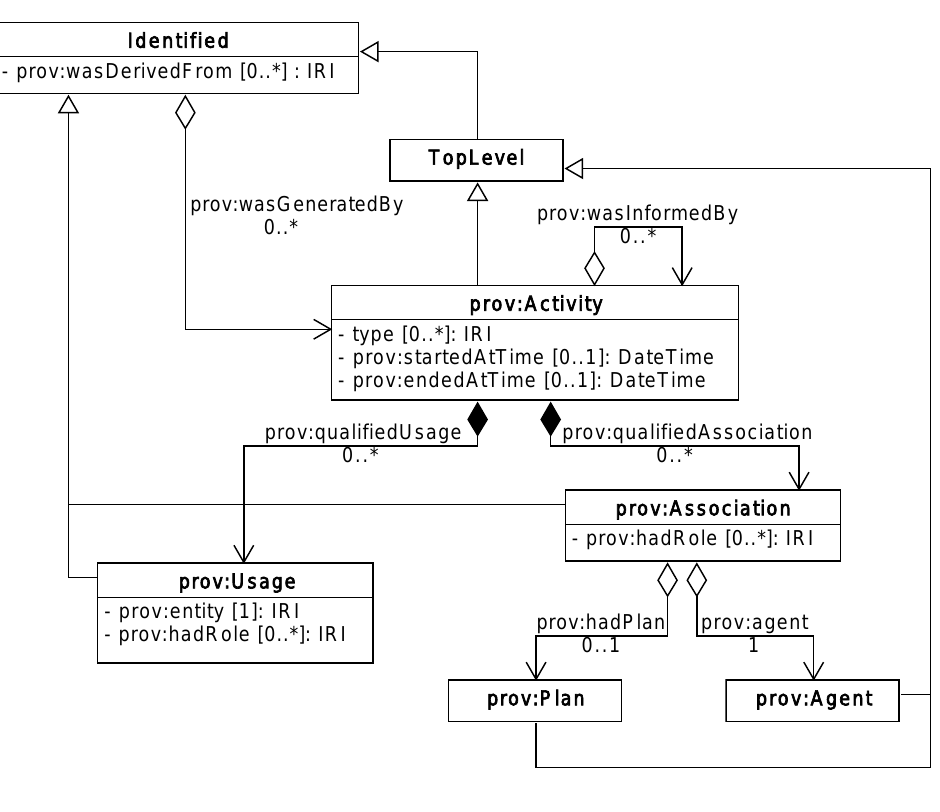
Figure 27: Relationships between SBOL and PROV-O classes. The PROV-O classes prov:Activity , prov:Plan , and prov:Agent all derive from TopLevel in the context of the SBOL data